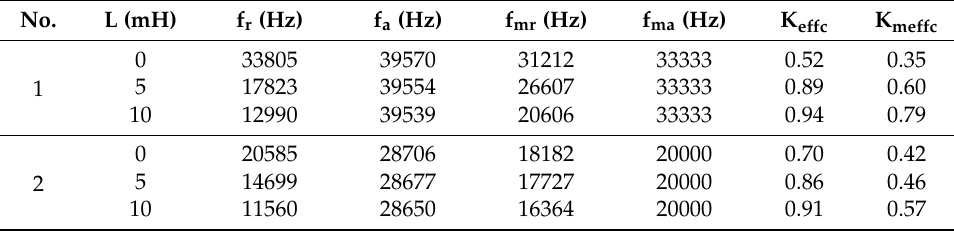
Table 1. Experimental resonance/anti-resonance frequencies and effective electromechanical coupling coefficient of the piezoelectric